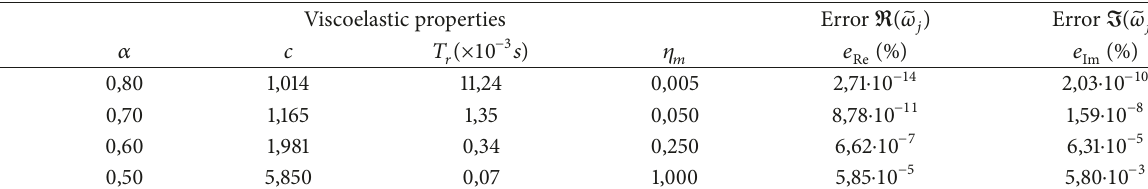
Table 3: Example 2: viscoelastic 1D structures. Damping parameters of the viscoelastic model based on fractional derivatives and numerical cases defined for the beam model. Last three columns show the maximum error in the real part, 𝑒 Re , and imaginary part, 𝑒 Im , in the computation of the complex frequencies.